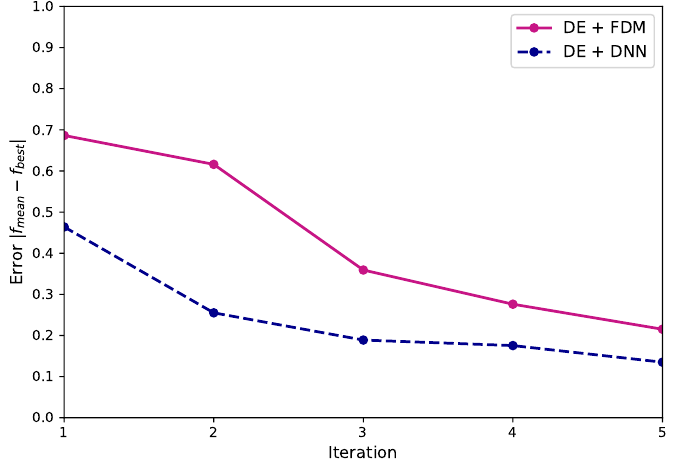
Figure 13. Relationship between the iteration and error for the 3D-truncated tetrahedron tensegrity using an FDM and a DNN-based form-finding method with a DE